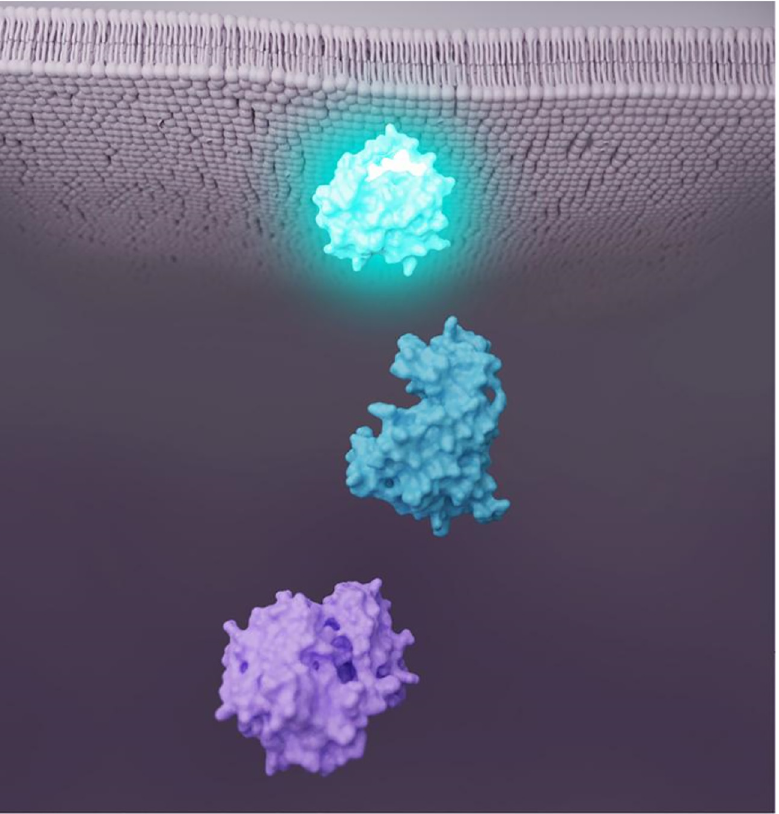
Figure 6: Considering best practices in color palettes for molecular visualisations: simple biomedical illustration depicting key molecules in an intracellular metabolic pathway – the color here helps to give functional meaning to the visualisation: similar colors show that the three molecules are linked, and a color progression indicates the order of the molecules in the pathway ( © 2022 Garrison et al., CC BY 4.0